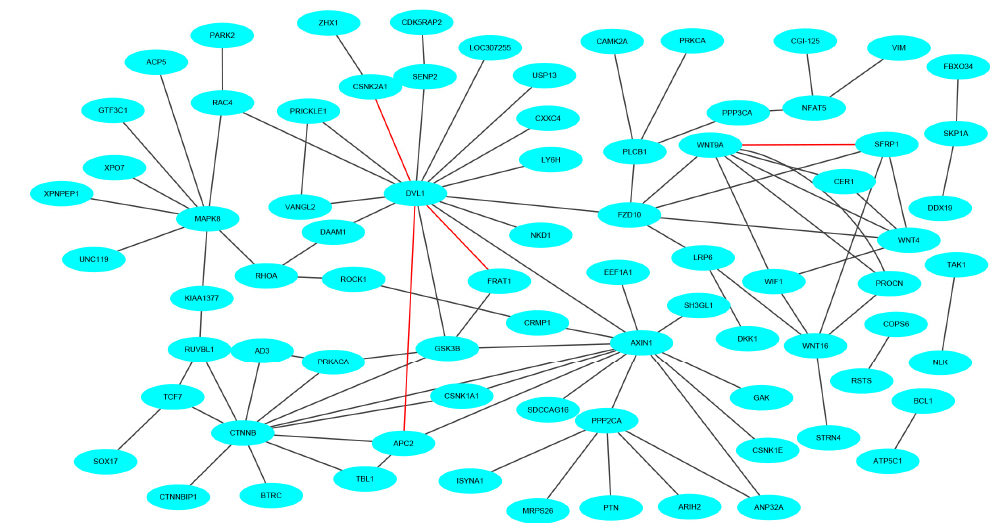
Figure 5. The prediction results of crossover network (Wnt-related network).